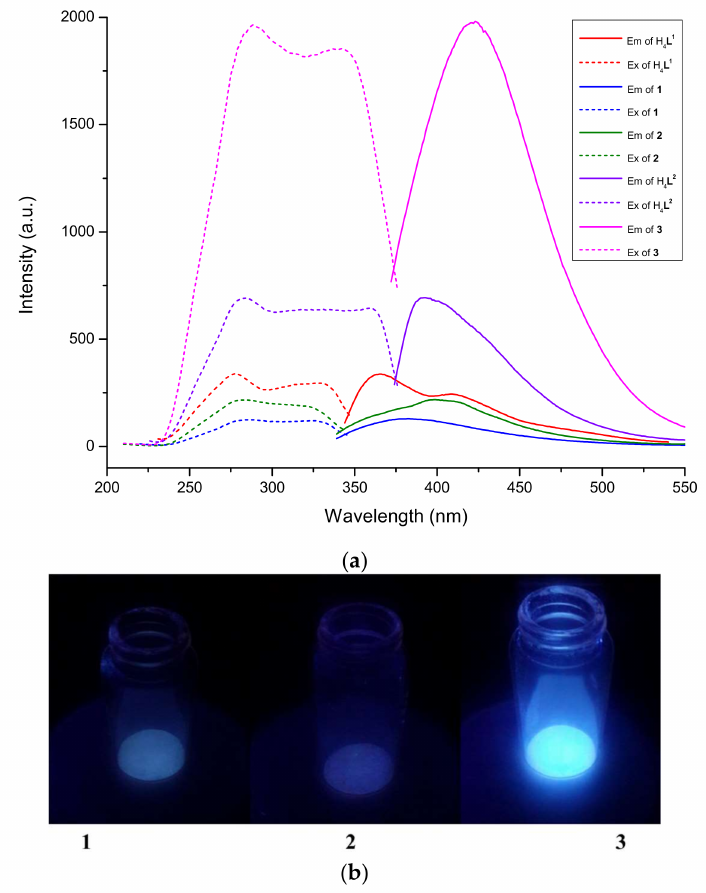
Figure 7. Emission and excitation spectra of ( a ) H 4 L 1 , 1 , 2 , H 4 L 2 and 3 ; ( b ) Images of powder 1 – 3 under a UV lamp at 365 nm in a dark